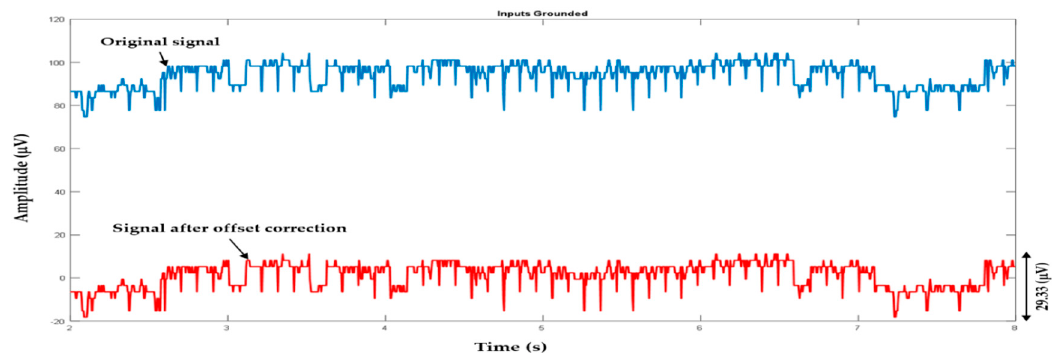
Figure 14. System output signals presented (electronic background noise) recorded when the system inputs were grounded for estimating error and offset correction figures.